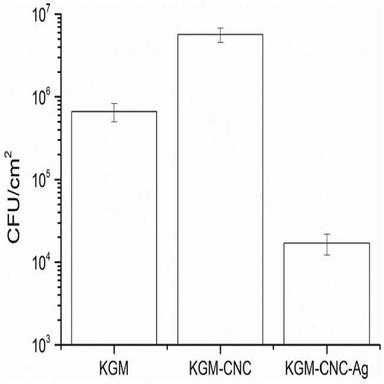
Number of adhered bacterial colonies (CFU/cm2 ) in KGM, KGM-CNC and KGM-CNC-Ag membranes.